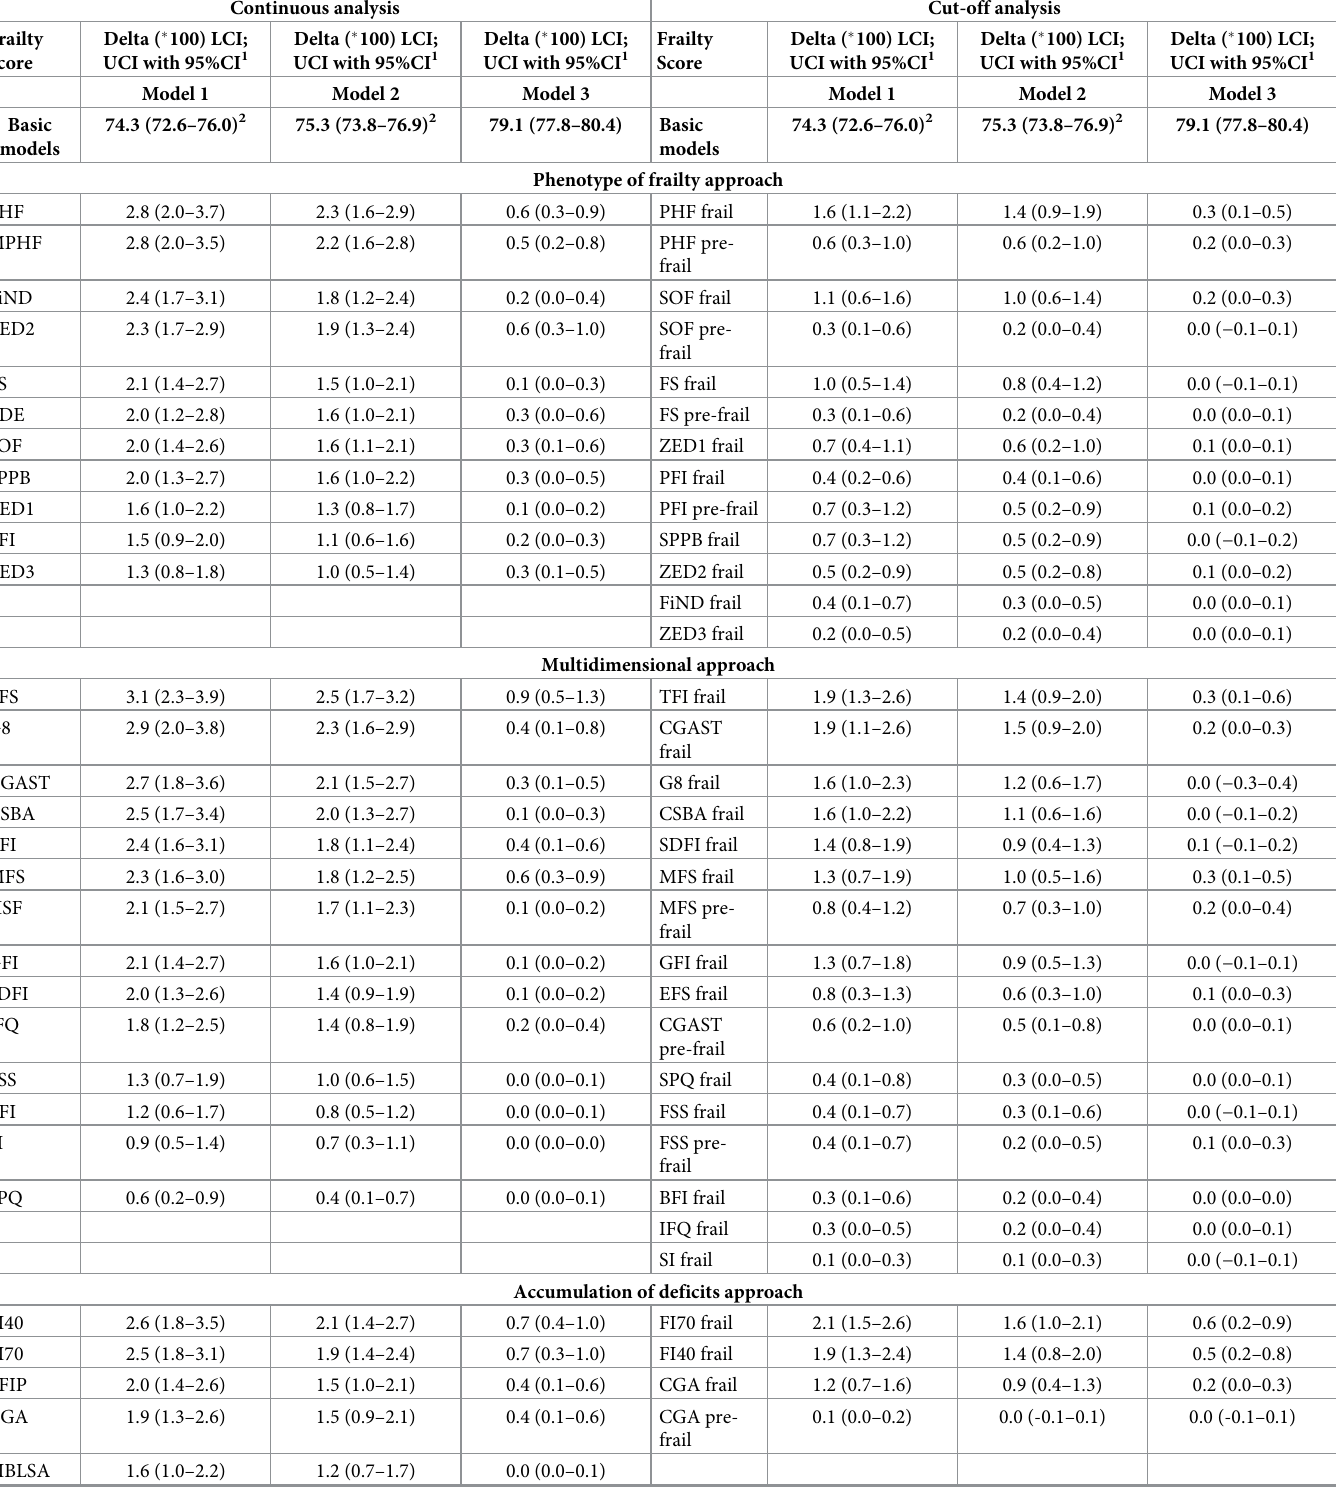
Table 4. Discriminative assessment of mortality models using Harrell’s C statistic ( n = 5,294). Continuous analysis Cut-off